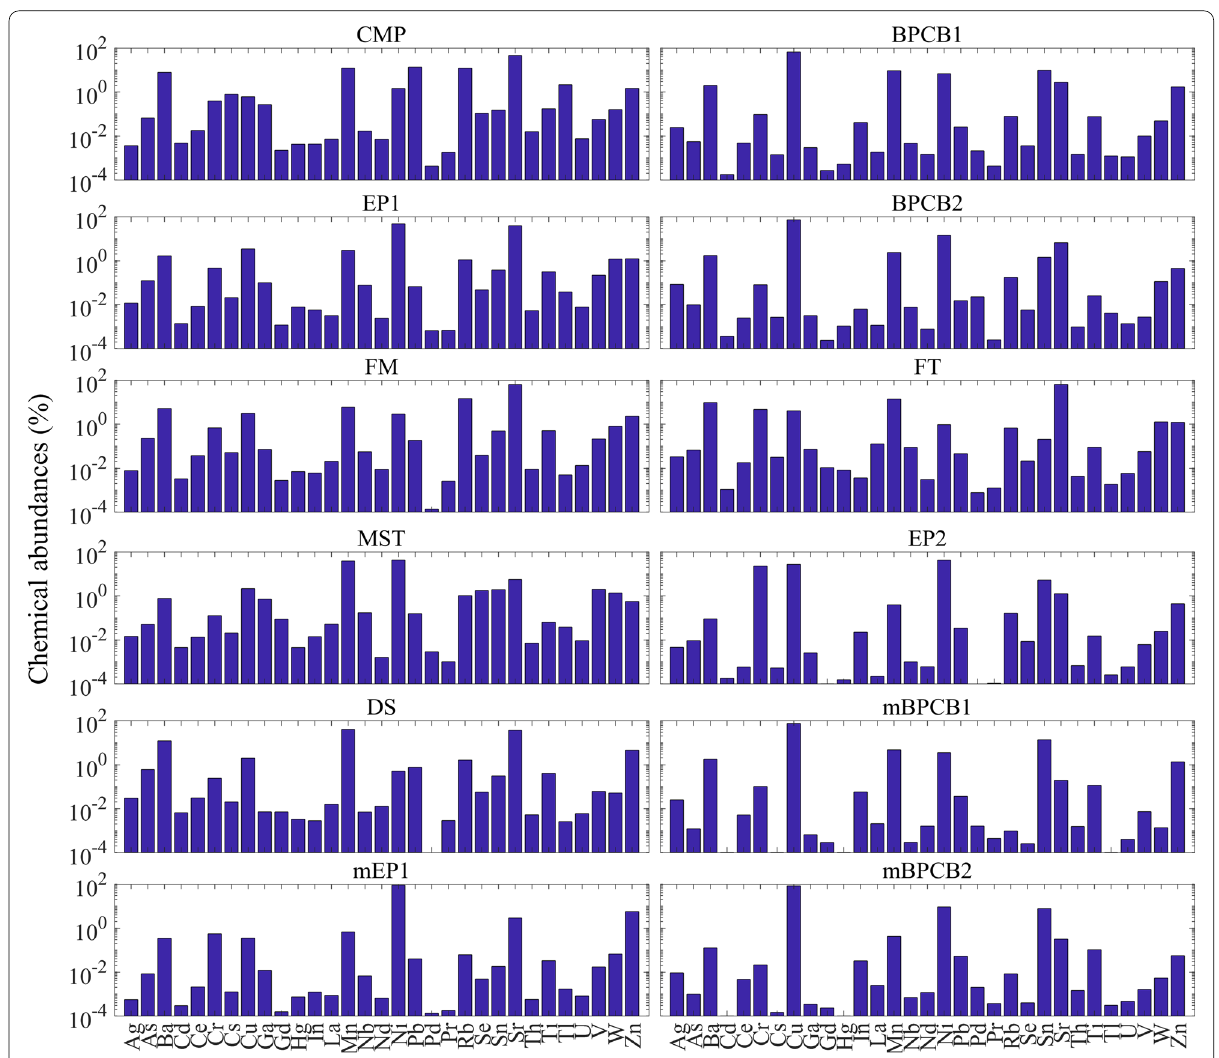
Fig. 4 Composite profiles of industrial effluents and manufacturing unit